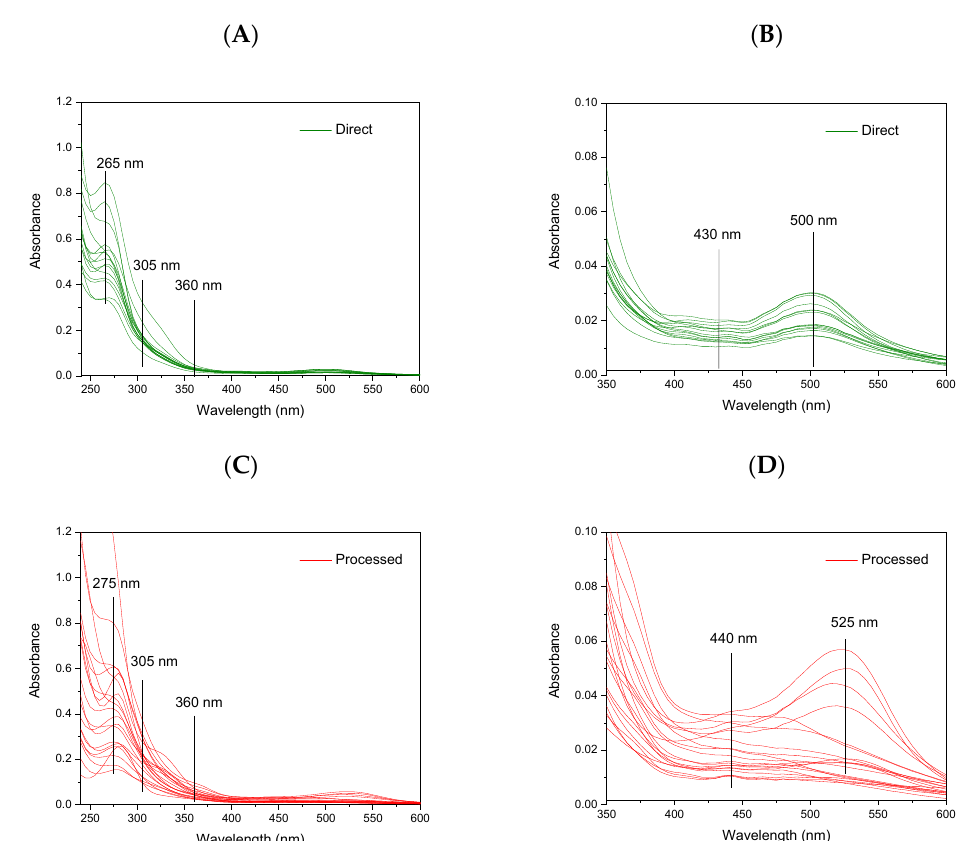
Figure 1. The absorption spectra of direct and processed strawberry beverages: Spectra of direct juices in the entire UV–vis region ( A ) and enlarged spectra in vis region ( B ). Spectra of processed beverages in the entire UV–vis region ( C ) and enlarged spectra in vis region ( D ).